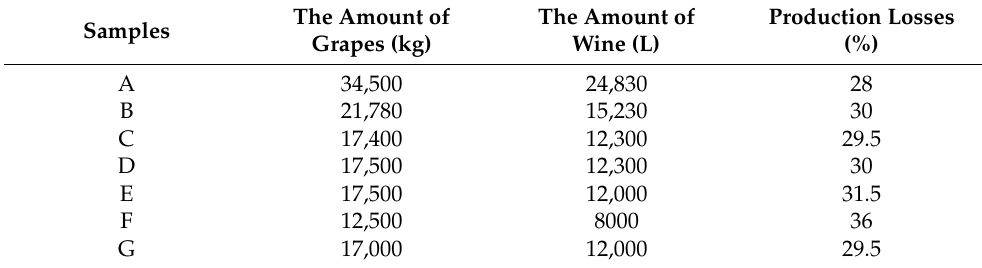
Table 5. Overview of the processed amount of grape